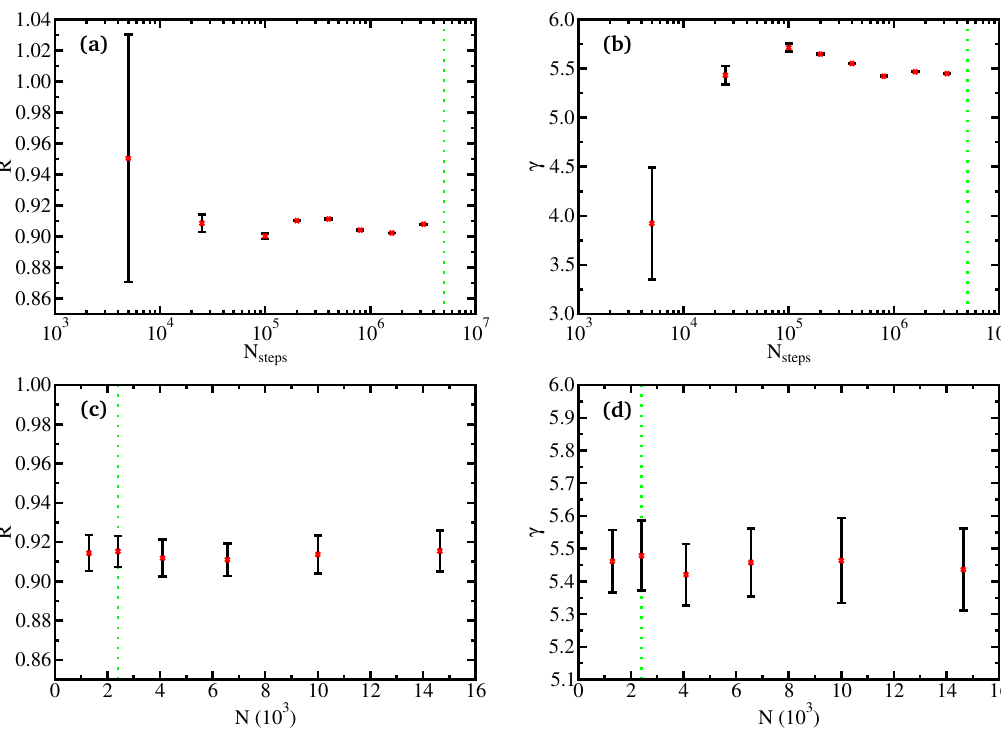
Figure 7: Influence of simulation length N (a)(b) and system size N (c)(d) on the steps estimated values of R and γ . The green vertical dotted line indicates the minimum simulation length (a)(b) or smallest system size (c)(d) of the article’s d = 4